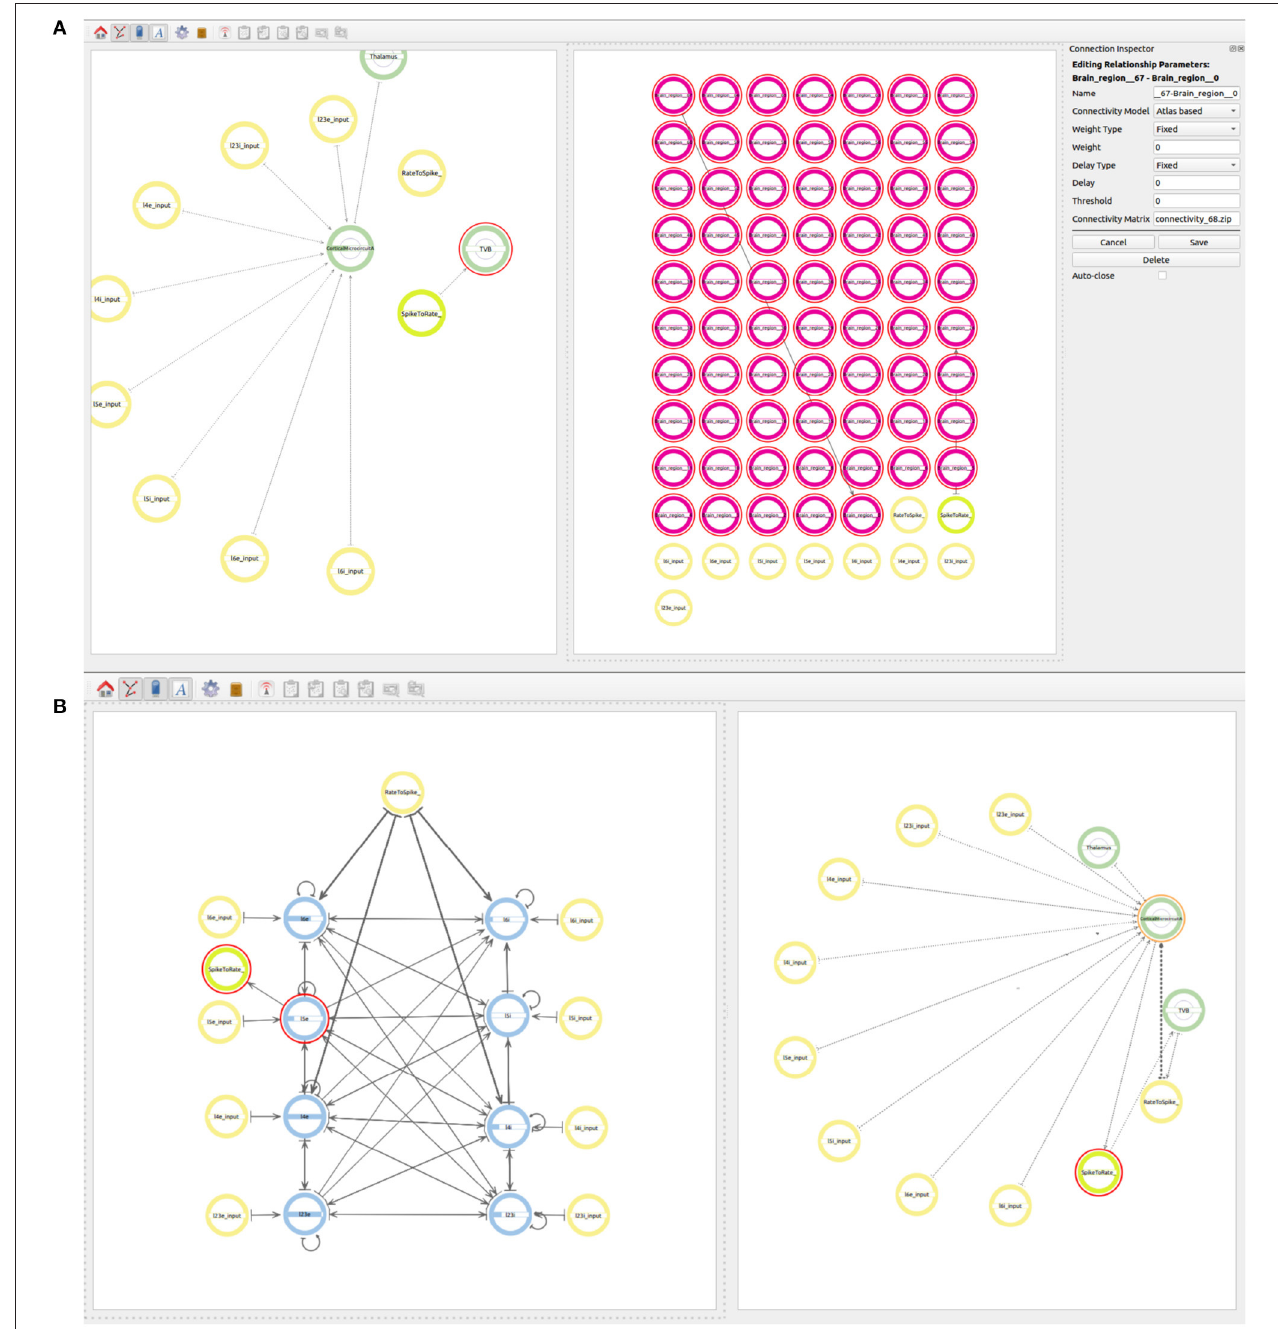
FIGURE 9 | Views of the multiscale model. (A) Establishing connectivity within the brain regions in the TVB super-population using the Atlas based connectivity. A single connection from Brain _ region _0 to Brain _ region _67 is used to specify the atlas based connectivity. The connection from region 27 to the rate to spike translator device is also visible at this step. (B) The final whole connectivity setup visualized on the right and the inside view of the cortical microcircuit model on the left.